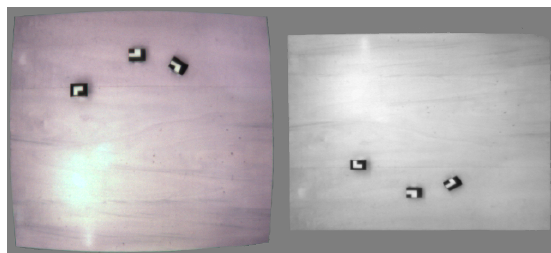
Figure 8. (i) Uncalibrated and (ii) Calibrated TestBed Images from the Video Tracking System